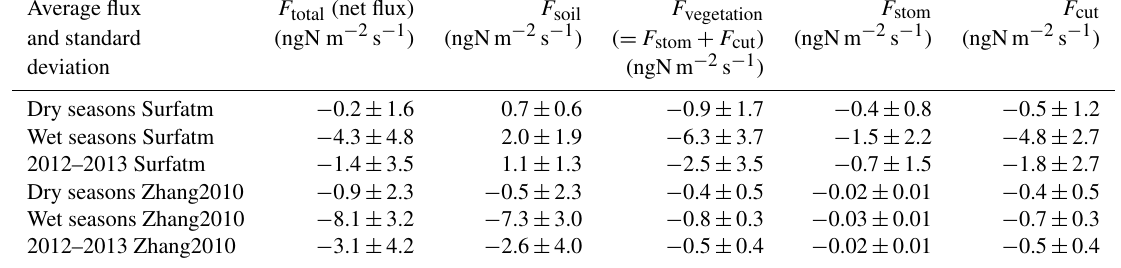
Table 4. Contributions of vegetation and soil to the total NH 3 flux in Surfatm and Zhang2010, wet season mean, dry season mean, and annual mean, for both years of simulation.